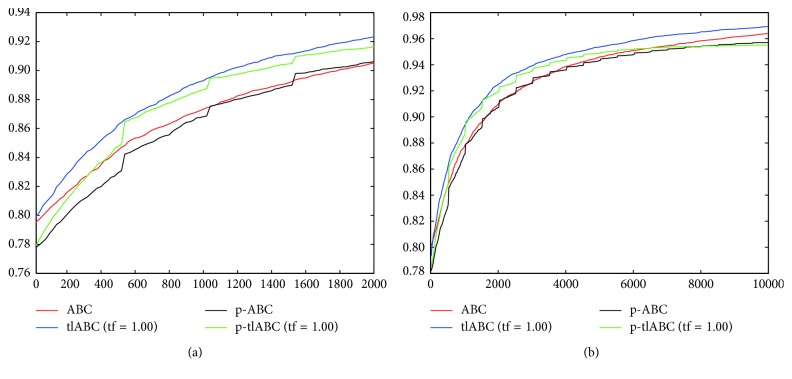
Convergence curves of ABC algorithms for 2, 000 (a) and 10, 000 (b) evaluations.